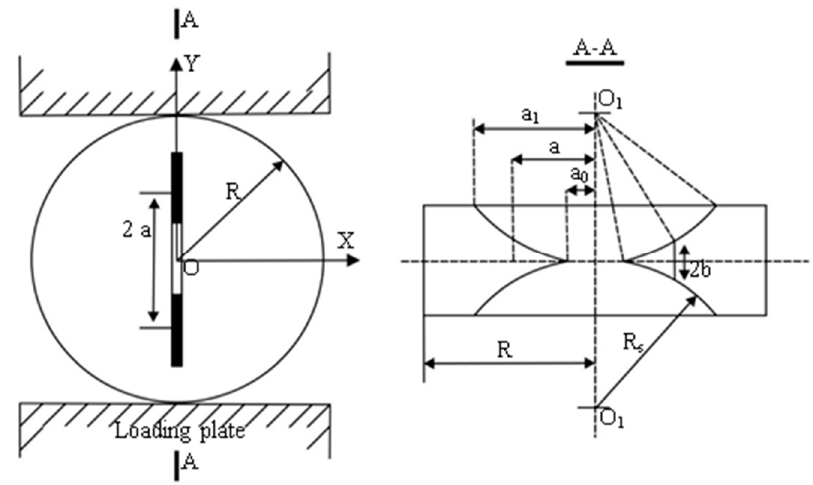
Figure 5. Geometry and loading condition of the CCNBD specimen [40].